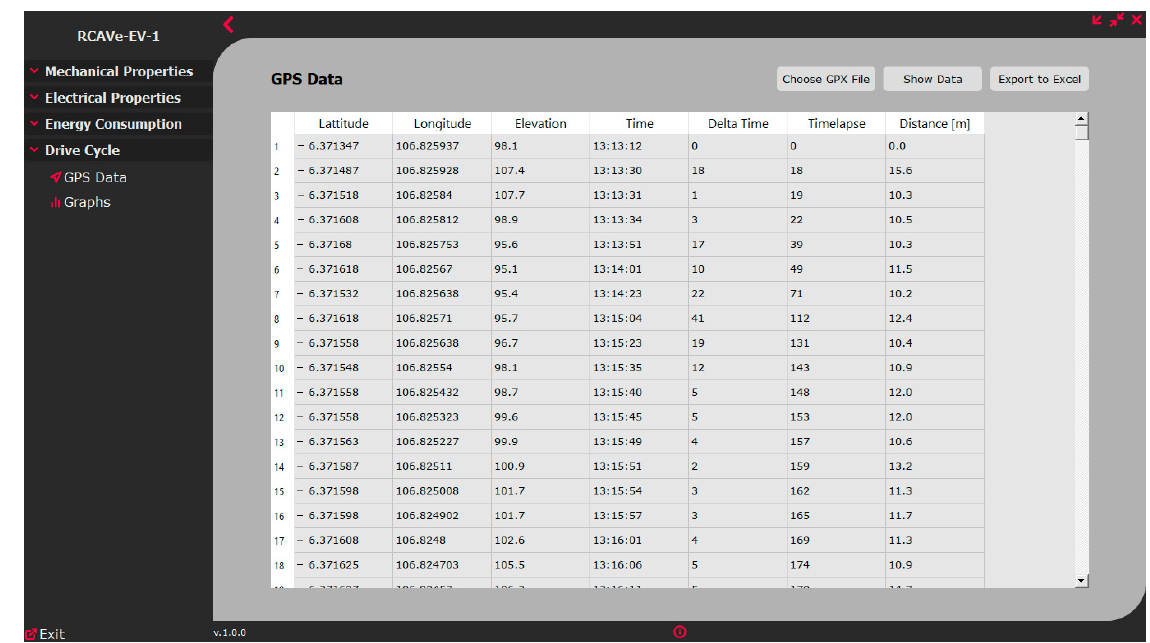
Figure 4. RCAVe-EV1 software—GeoTrack GPS data process.